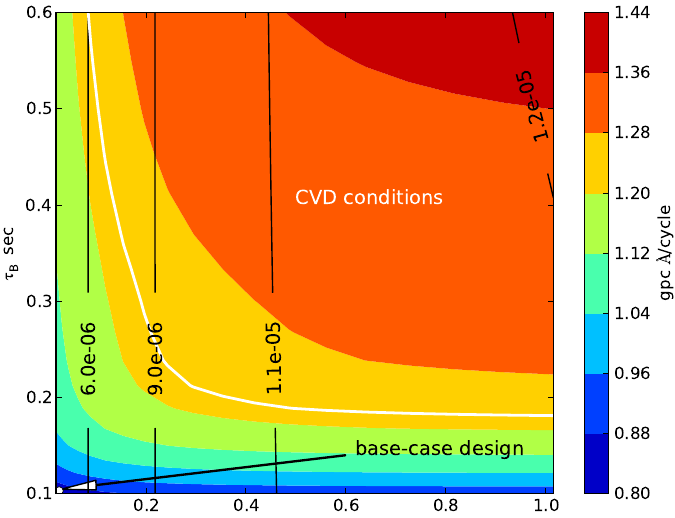
Figure 8. Growth per cycle ( gpc ) as a function of τ correspond to moles of TMA/cycle fed to the